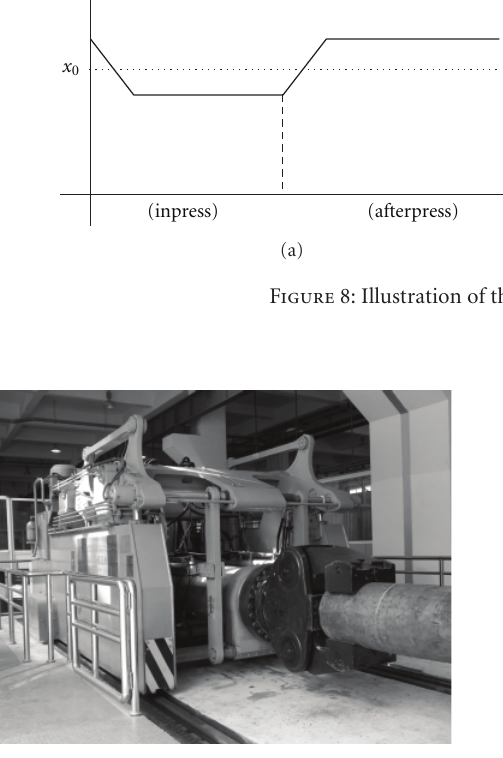
Figure 9: Prototype of the novel hydraulic forging manipulator.